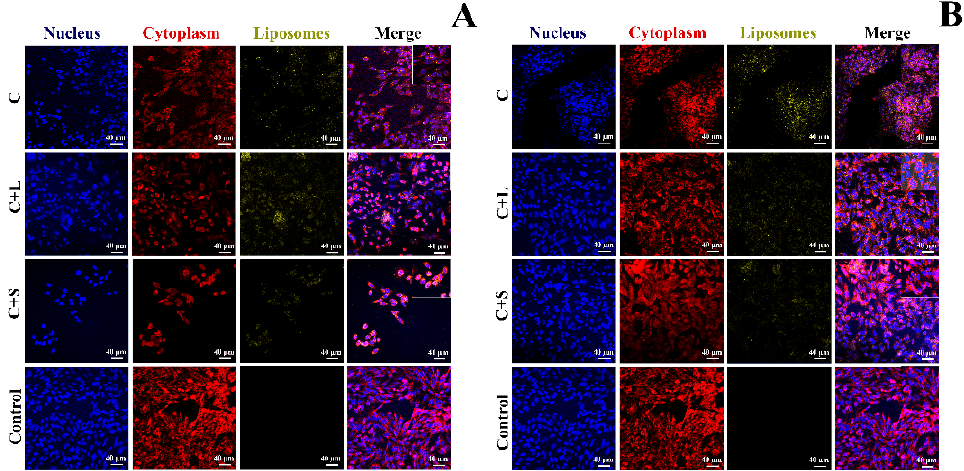
Figure 4. Confocal laser microscopy images obtained for coumarin liposomes without additive (C) and coumarin liposomes with lactose or sucrose (C + L or C + S, respectively), filtered through 0.20 µm ( A panel) or 0.45 µm filters ( B panel). Control: cells without liposomes.